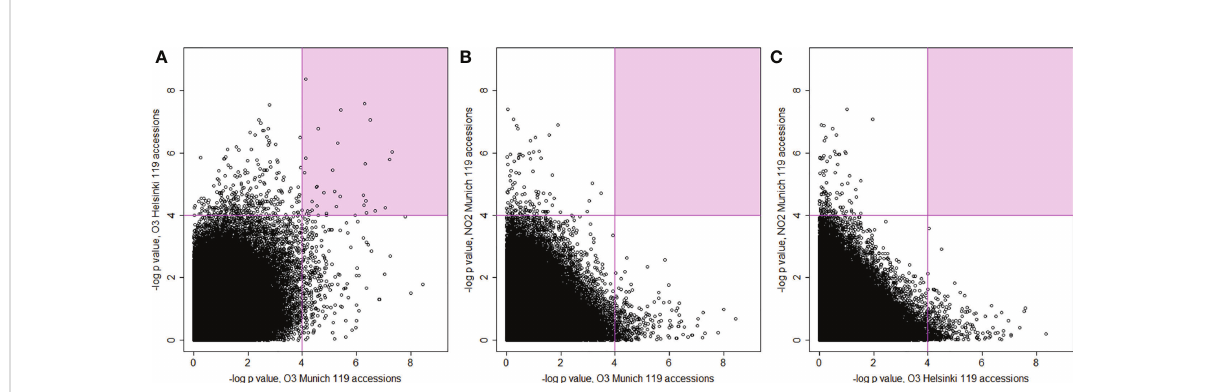
FIGURE 5 Scatterplots for the comparison and correlations between – log 10 P -values of SNPs from genome-wide association analysis (AMM) between the three experiments with 119 common accessions. (A) plotted P -values from O 3 fumigations conducted in Munich (x-axis) and in Helsinki (y-axis), (B) plotted P -values from O 3 fumigations in Munich (x-axis) and NO 2 fumigations (y-axis), (C) plotted P -values from O 3 fumigations in Helsinki (x-axis) and NO 2 fumigations (y-axis). The areas with the smallest P -values ( – log 10 P -value > 4) have coloured